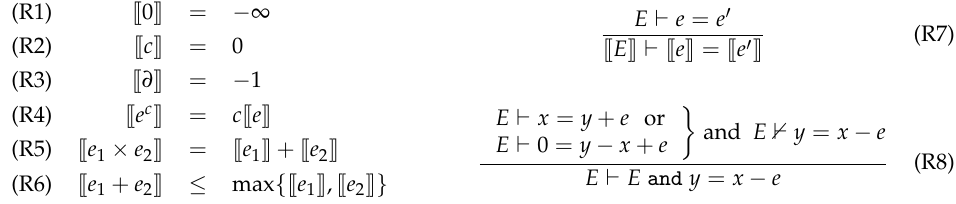
e , then we − y = x e . ⇒ − 1609 1610 1611